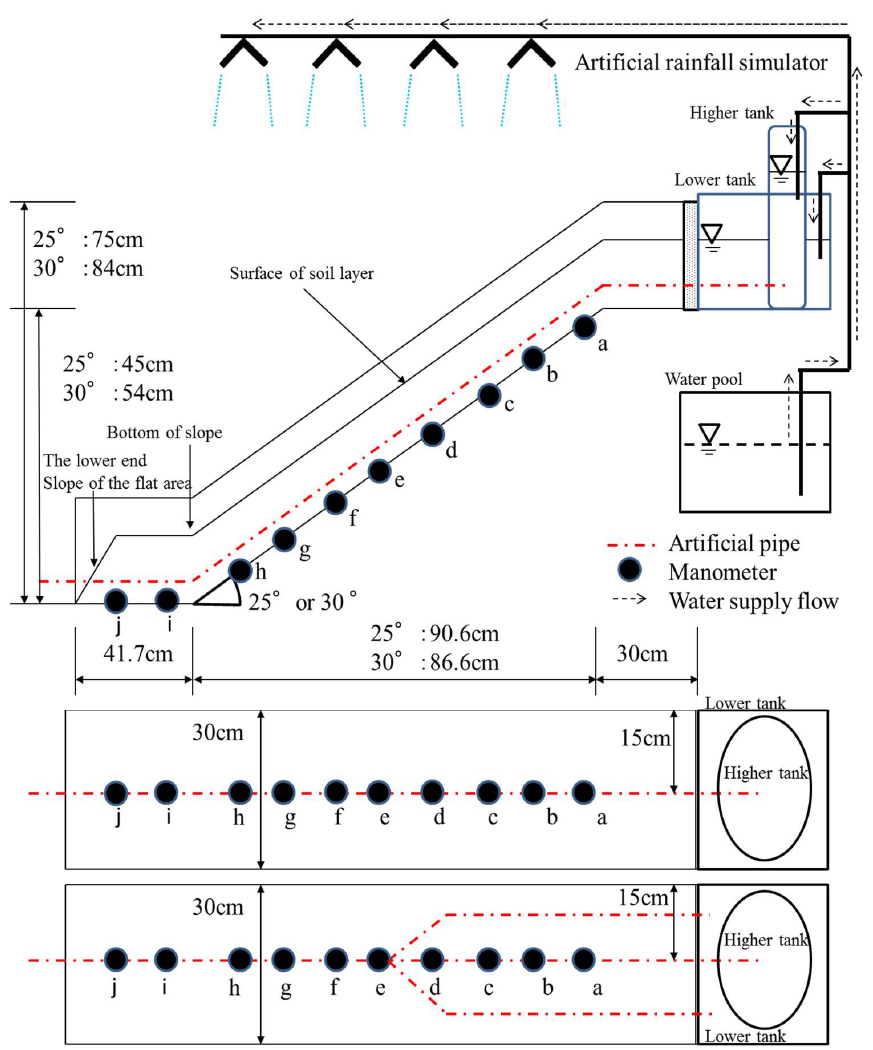
Figure 1. Overview of the equipment. We prepared slopes with two different gradients and set the depth of the soil layer to 20 cm. The water supply system consists of the higher and lower tanks, and artificial rainfall simulator. We supplied water from the water pool to the artificial rainfall simulator and the higher and lower tanks using a pump. We pierced the artificial pipe, which was made of vinyl chloride, so that water could pass through it. We installed the artificial pipe at the bottom of the model slope. Moreover, we measured the pore water pressure with a manometer attached to the bottom of the model slope.